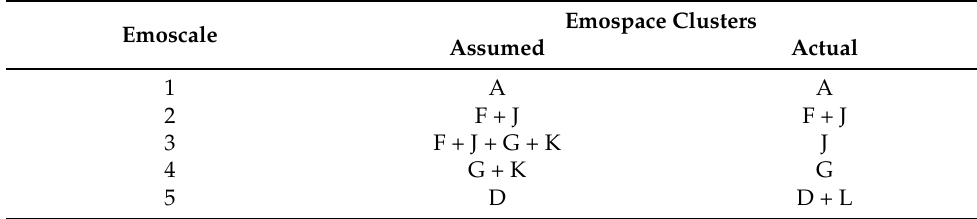
Table 1. A comparison of emoscale ratings and emospace clusters.